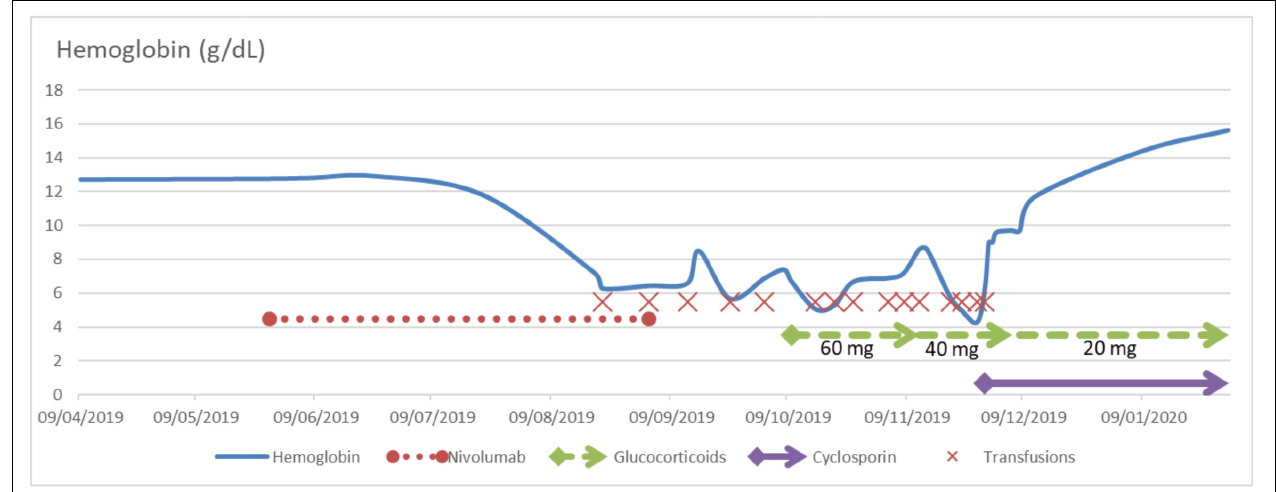
FIGURE 1 | Hemoglobin level as a function of time and treatments. Doses of oral steroids are specified below the respective arrows. Intravenous cyclosporin was introduced at 3 mg/kg for 3 days before being switched for oral cyclosporin 80 mg twice a day with a slow taper.